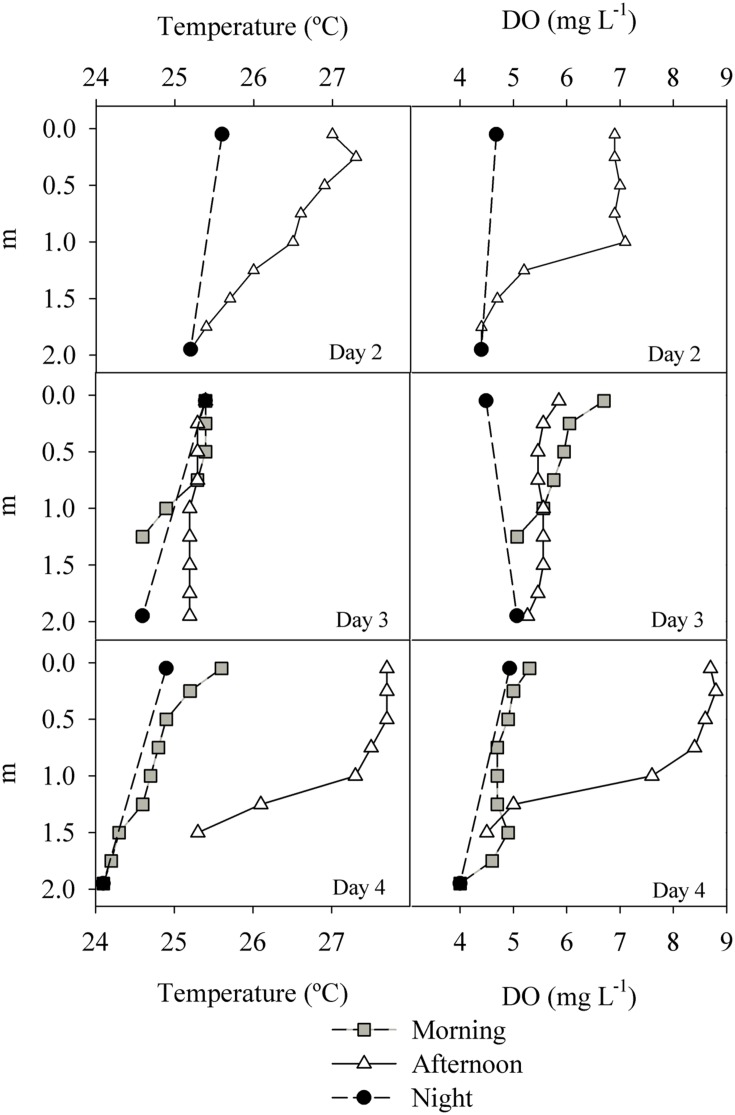
Temperature and DO profiles measured in the ESEC reservoir between July 15th and 17th (“Day 2” and “Day 4”). Night profiles refer to measurements taken right before dawn.